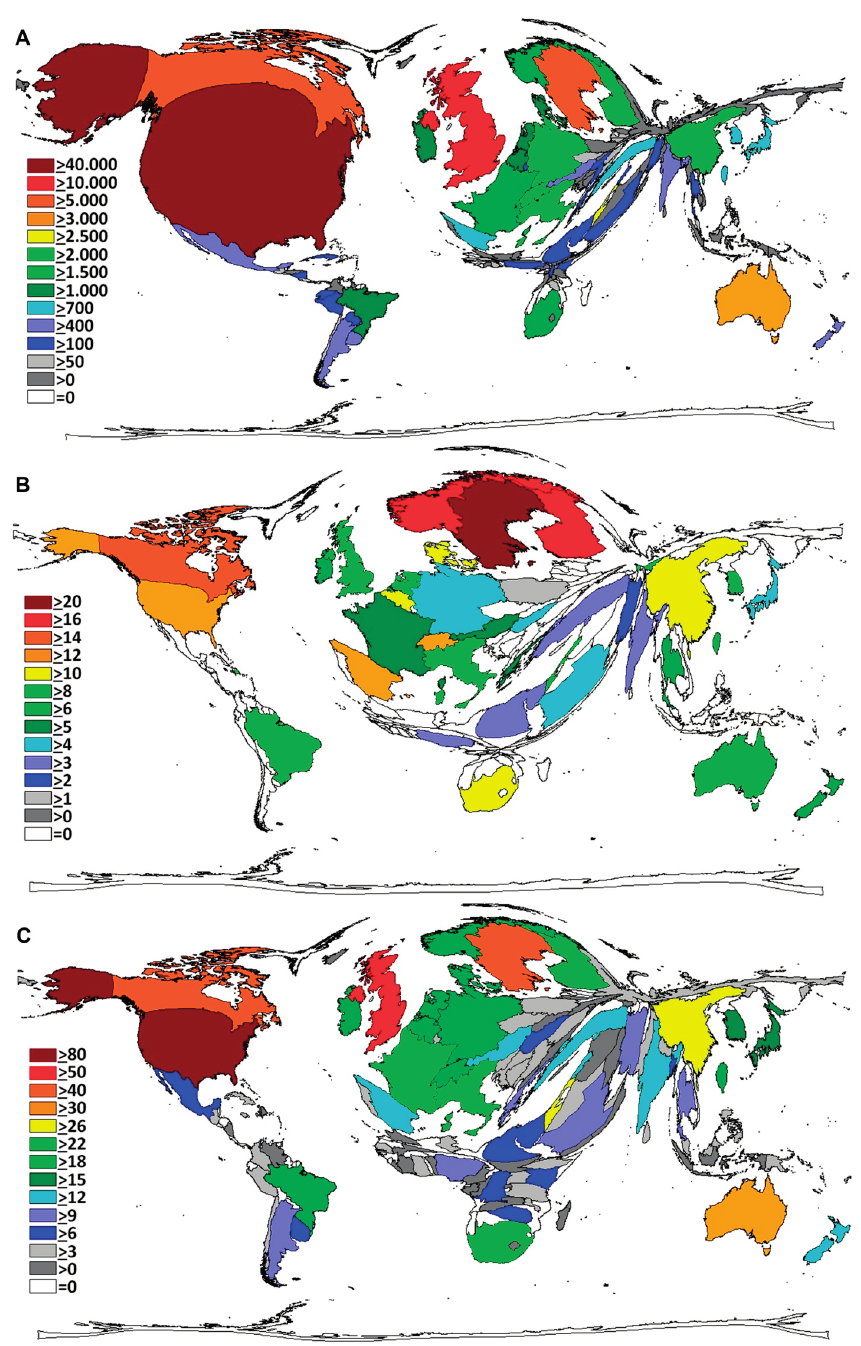
Figure 2. Density-equalizing Map Projections. ( A ) Country specific number of citations of caesarean section publications. The area of each country was scaled in proportion to its total number of citations. Colours encode numbers of citations. ( B ) Country specific citation rate (Citations per publication). The area of each country was scaled in proportion to the citation rate levels. ( C ) Country specific h-Index. Colours encode h-Index